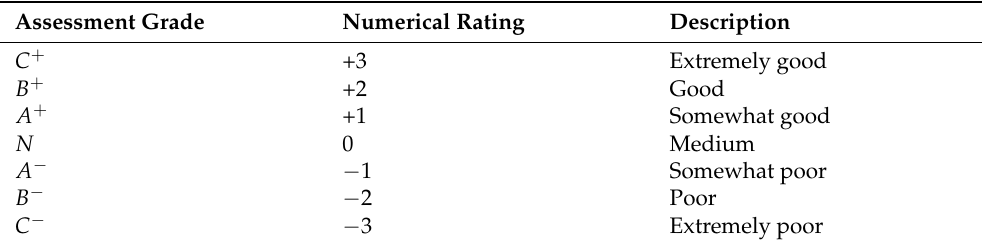
Table 2. The assessment standard for D